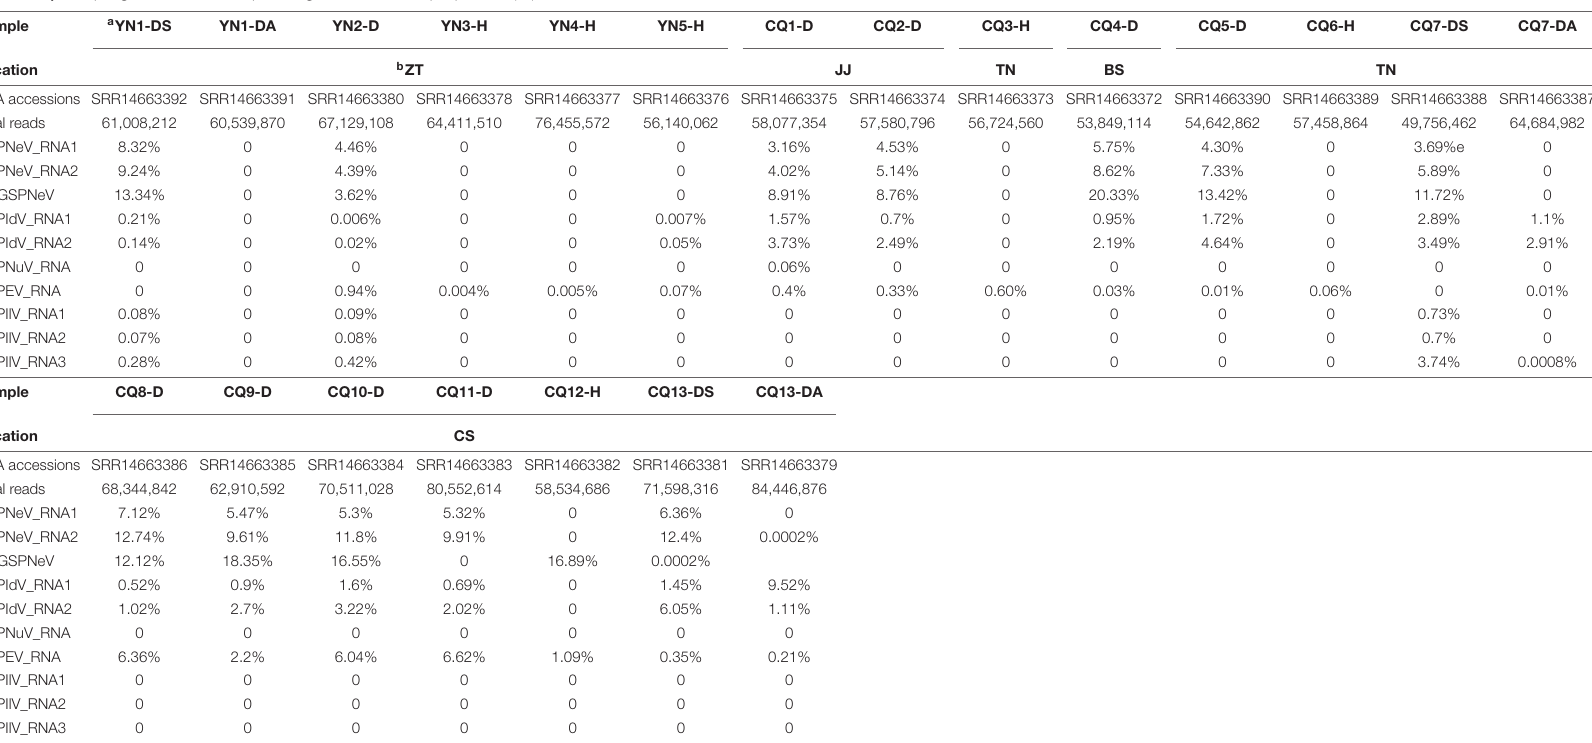
TABLE 1 | Sampling information, sequencing data size, and proportion (%) of viral/subviral RNA reads in total reads. Sample Location